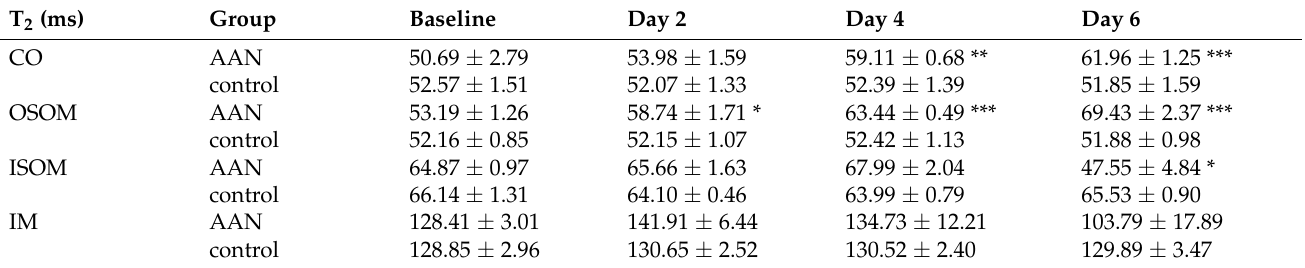
Table 1. Summary of T 2 relaxation times obtained for the AAN group and for the control group. T 2